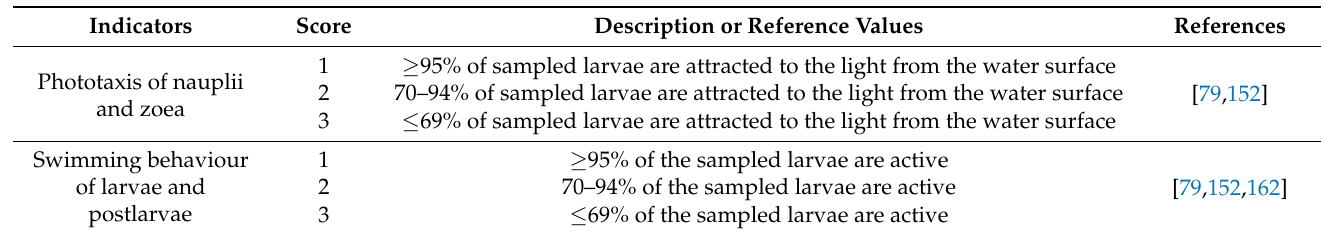
Table 9. Behavioural indicators for larvae and postlarvae of Penaeus vannamei